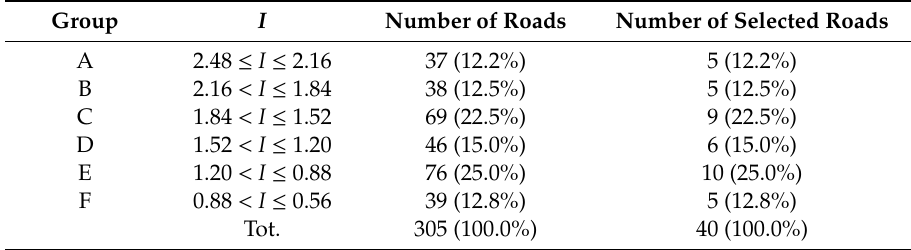
Table 1. Range of values of the I index for the selection of the 40 roads.